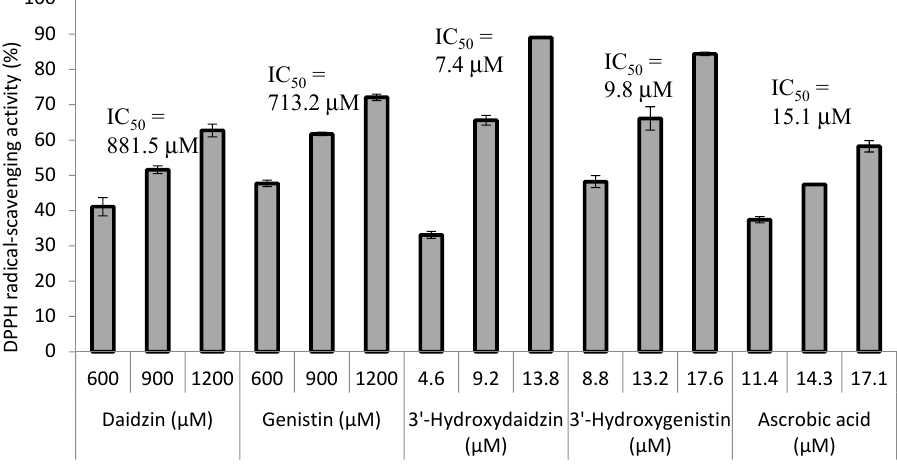
Figure 4. DPPH radical-scavenging activity of soy isoflavones and ascorbic acid. The DPPH scavenging activity was determined as previously described [10]. The IC 50 values represent the concentrations required for 50% DPPH radical-scavenging activity. The mean ( n = 3) is shown, and the standard deviations are represented by error bars.